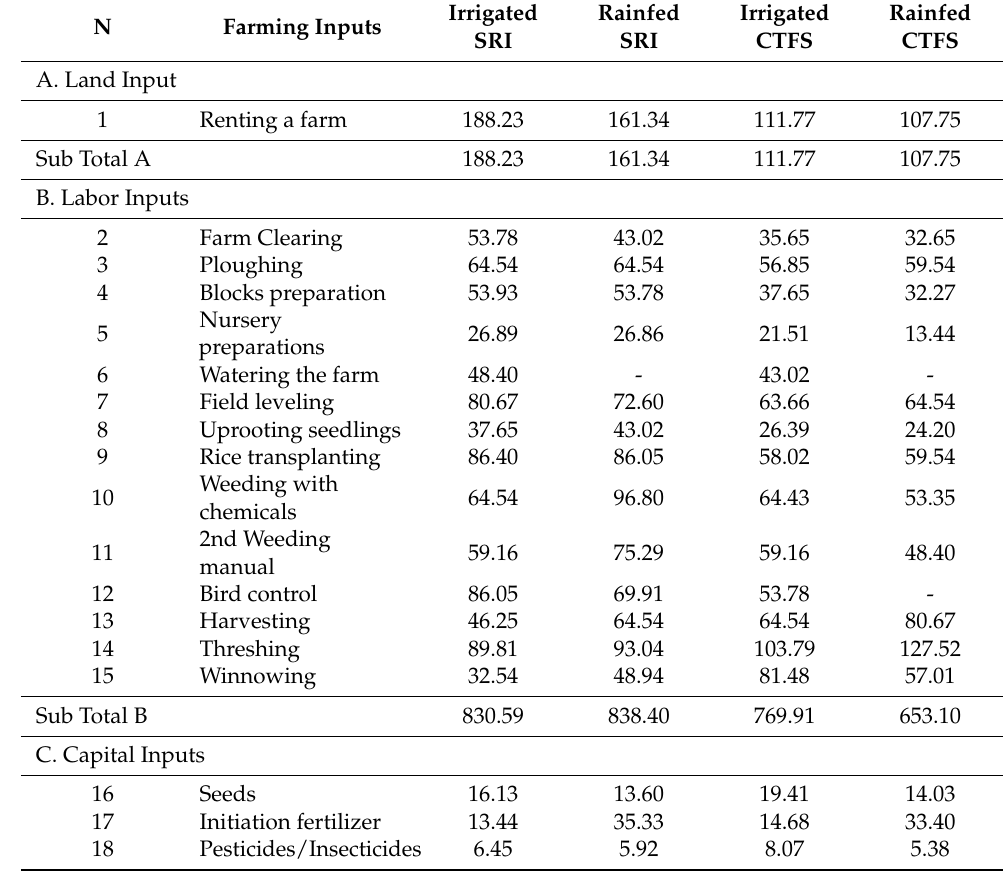
Table 6. Average annual value of input of production, based on 1 ha of